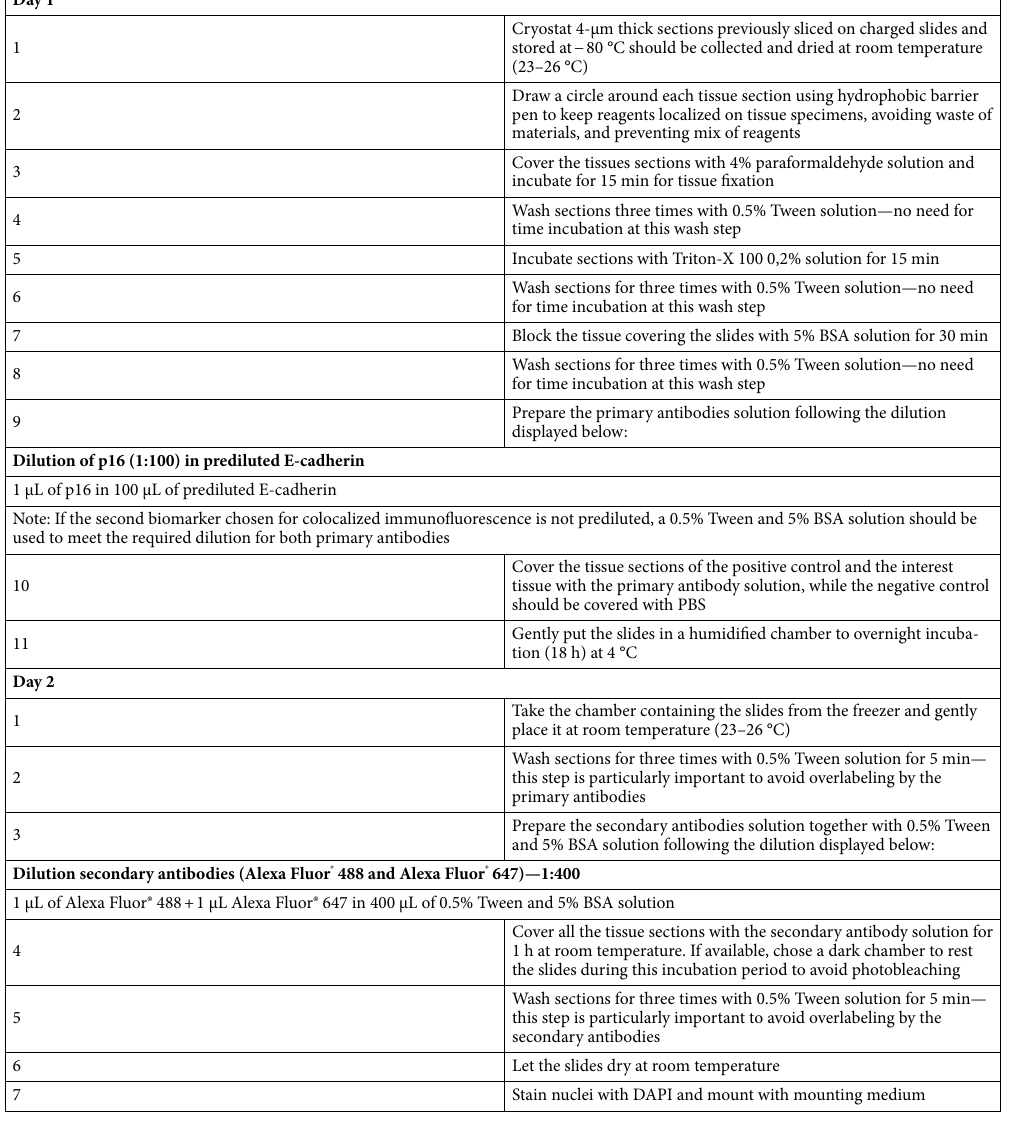
Table 1. p16 immunofluorescence staining protocol for endometriosis